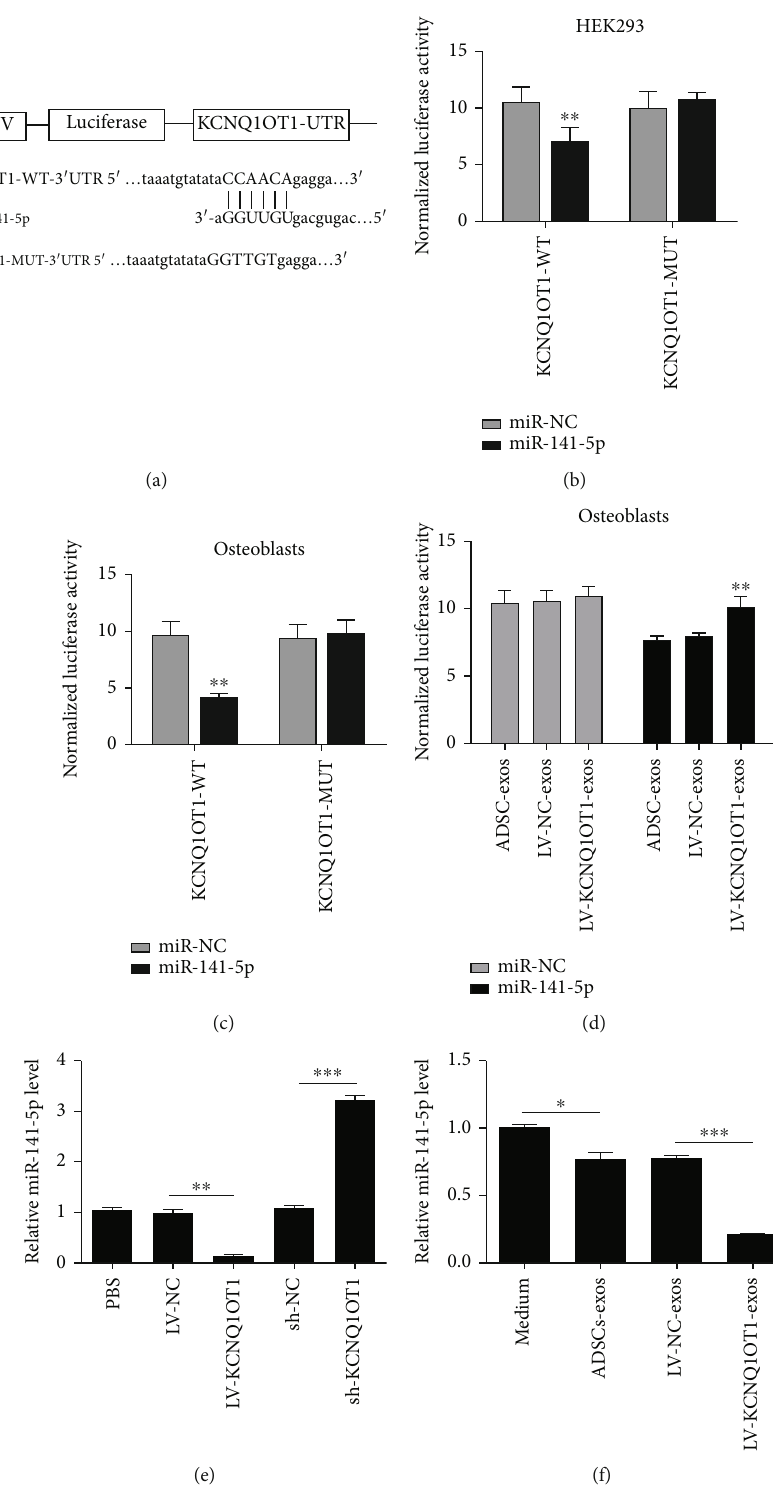
Figure 6: KCNQ1OT1 can sponge miR-141-5p. (a) KCNQ1OT1 and miR-141-5p have potential binding sites. (b, c) As dual-luciferase reporter assay showed, miR-141-5p weakened the luciferase activity in the KCNQ1OT1-WT group obviously, but the activity of luciferase reporters containing KCNQ1OT1-MUT was not changed signi fi cantly in both HEK293 and primary osteoblasts. (d) LV- KCNQ1OT1-Exos blocked the inhibitory e ff ect of miR-141-5p on the luciferase activity of reporters containing KCNQ1OT1-WT compared with ADSC-Exos and LV-NC-Exos. (e) KCNQ1OT1 suppressed the expression of miR-141-5p, but the sh-KCNQ1OT1 increased that. (f) The expression of miR-141-5p was downregulated when primary osteoblasts were cocultured with LV-KCNQ1OT1- Exos. ∗ P < 0 : 05 , ∗∗ P < 0 : 01 , and ∗∗∗ P < 0 : 001